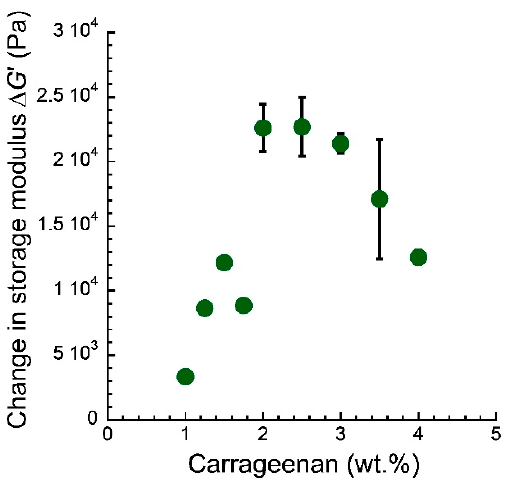
Figure 3. The relationship between the change in storage modulus and carrageenan concentration for magnetic gels with a concentration of 50 wt.%.